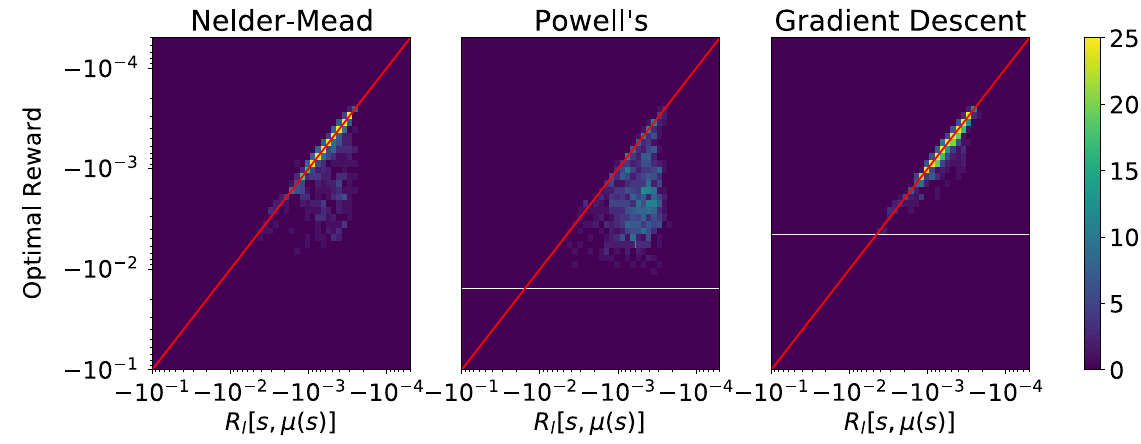
FIG. 6. Comparison of the evaluated RL policy μ ð s Þ with the best reward achieved by the different optimization methods after 1000 reward function evaluations; Because the local optimization algorithms are stochastic, i.e., depend on random variables, we run the optimization algorithms 800 times to get a reliable amount of statistics. We plot the histograms with respect to the optimal rewards of our RL agent. The intensity shows how many runs of the stochastic optimizations have achieved a particular optimal reward. In case one method is performing equally as RL, only the bisecting line (highlighted in red) will be visible. If there is intensity below this line, the optimization method could not achieve a similar or better reward than the RL policy μ ð s Þ within the allowed reward function evaluations. Note the logarithmic scale on both